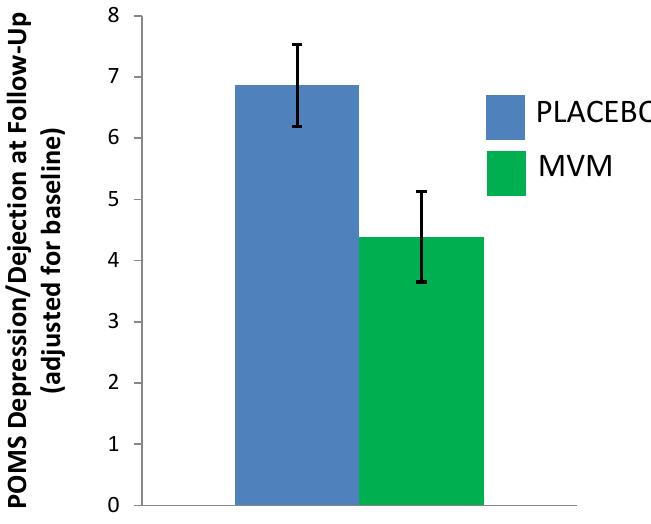
Figure 2. Post-treatment depression/dejection scores (POMS), adjusting for baseline (estimated marginal means, error bars ± 1 SE). MVM: Multivitamin/mineral treatment group.